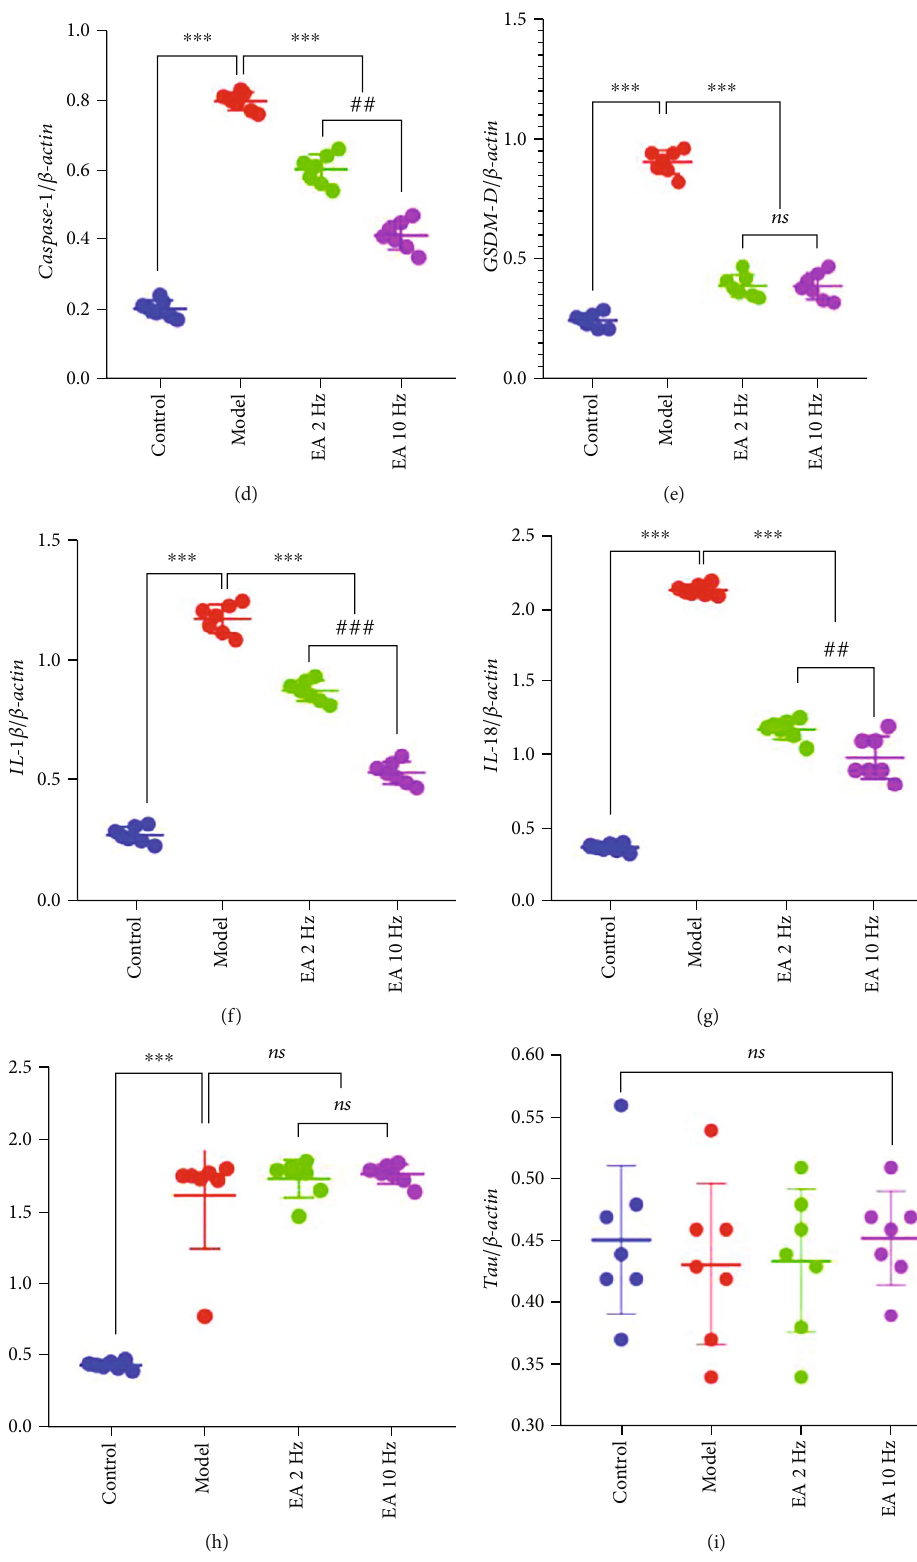
Figure 6: Expression of NLRP3/caspase-1 signaling-related proteins in the hippocampal tissue. (a) Western blot images showing the protein levels of NLRP3, ASC, caspase-1, GSDM-D, IL-1 β , IL-18, A β , and tau in the hippocampus. (b – i) Quanti fi cation of NLRP3, ASC, caspase-1, GSDM-D, IL-1 β , IL-18, A β , and tau bands in the hippocampus. Data are presented as the means ± standard errorof the mean ( n = 7 per group). ∗∗∗ P < 0 : 001 vs. the model group; ### P < 0 : 001 and ## P < 0 : 01 vs. the 2 Hz EA group. ns: not signi fi